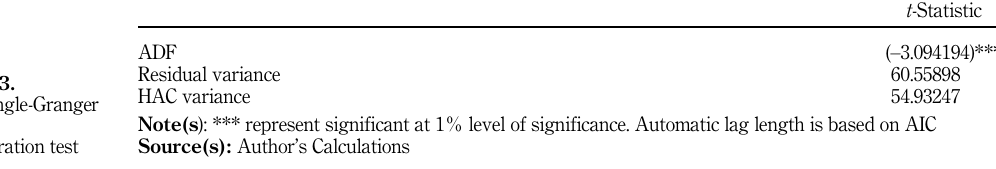
based) cointegration